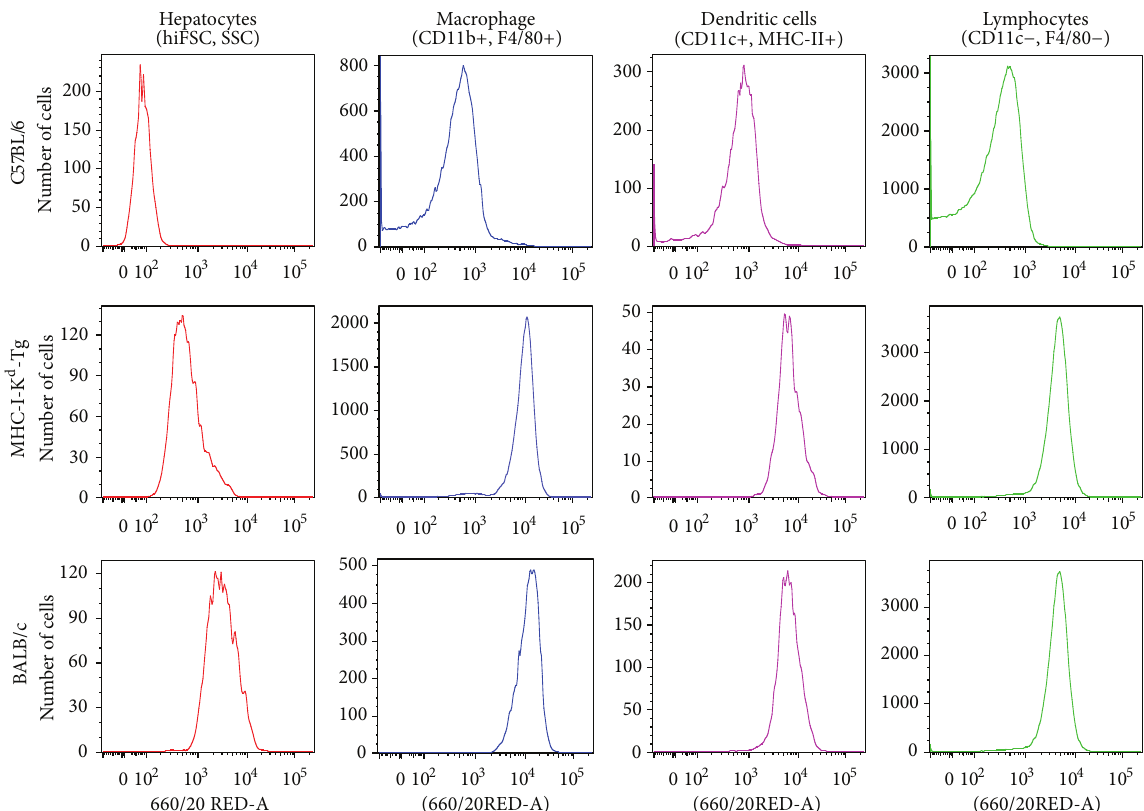
Figure 1: Phenotype of MHC-I- 𝐾 𝑑 -Tg mice . Histograms show H-2K d expression levels on hepatocytes, macrophages, dendritic cells, and lymphocytes of C57BL/6 (B6), MHC-I-K d -Tg, and BALB/c. Hepatocytes were isolated from mouse liver and then gated based on high FSC/SSC parameters. Macrophages were gated on CD11b+/F4/80+ and CD11c+/MHC II+ were used to define dendritic cells. Lymphocytes were identified by CD11c − /F4/80 −